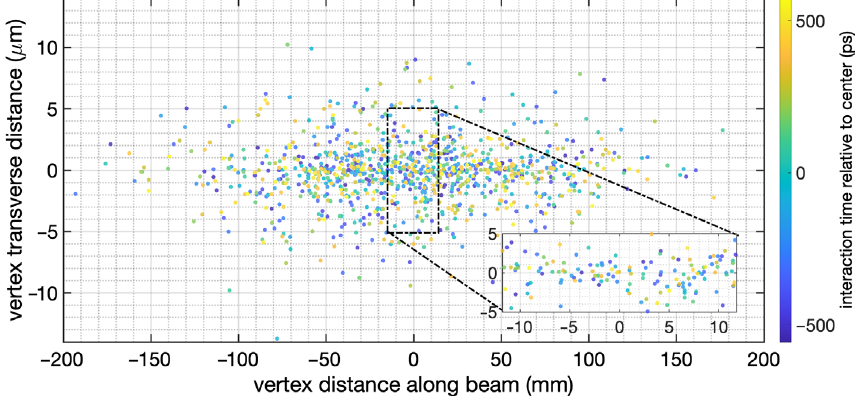
FIG. 28. A simulation of the FCC-hh luminous region for a single event, based on the expected bunch sizes and interaction rate. The inset shows the core region, and the colors encode the time of the interaction at each vertex relative to the center